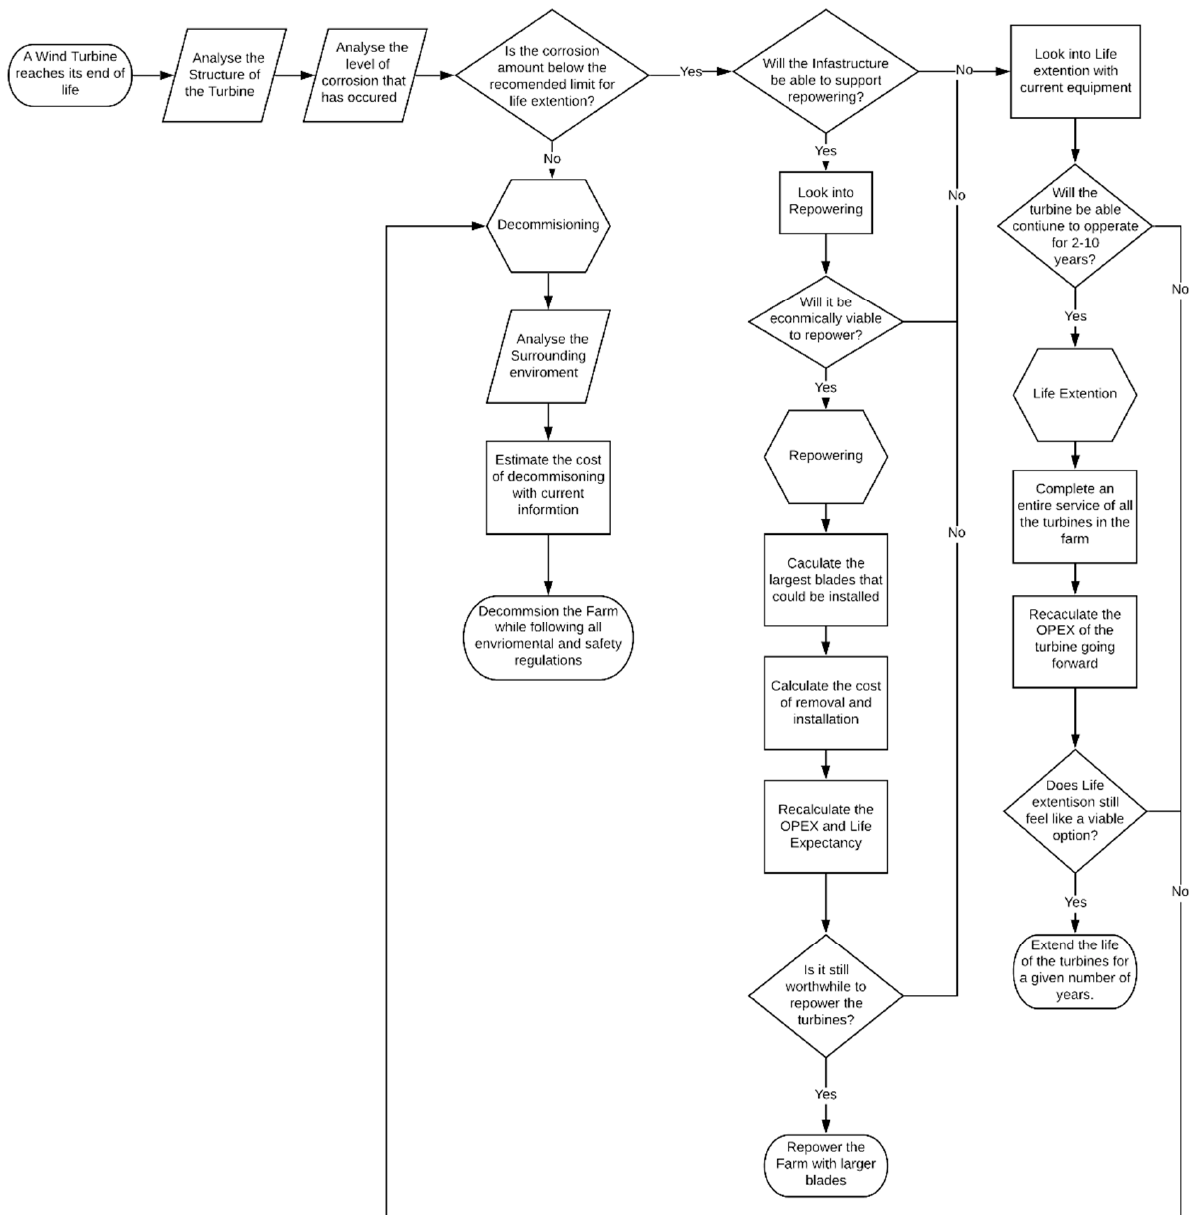
Figure 7. Flowchart of possible routes when looking at ageing offshore wind